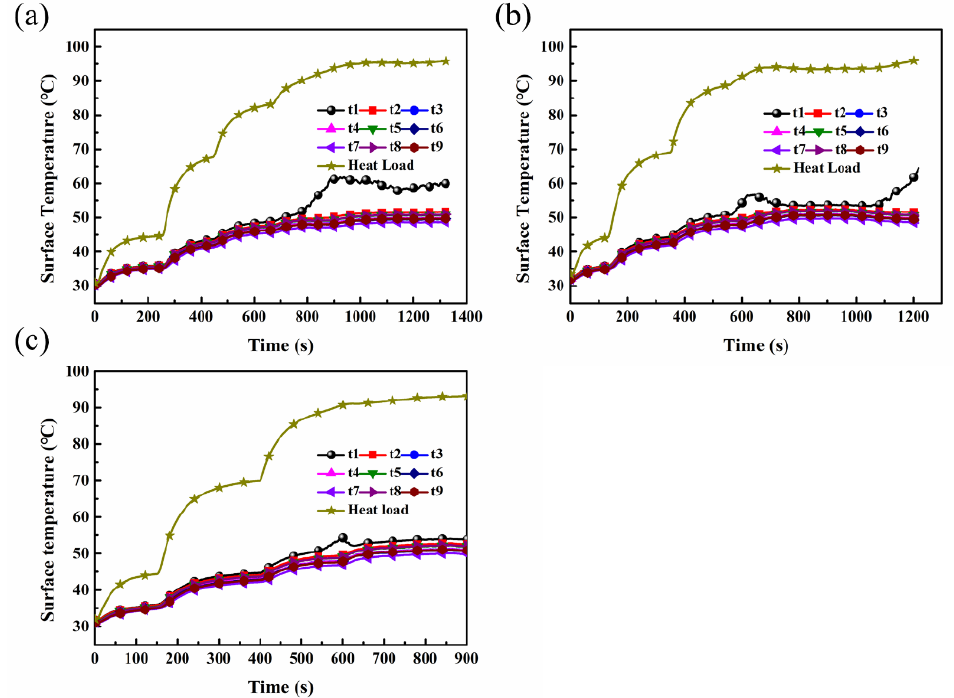
Figure 6. The surface temperature distribution of TGHP − 1 after exceeding the threshold critical power (heat load A was 65 W) with different heat load B, including ( a ) 2 W, ( b ) 4 W, and ( c ) 6 W.